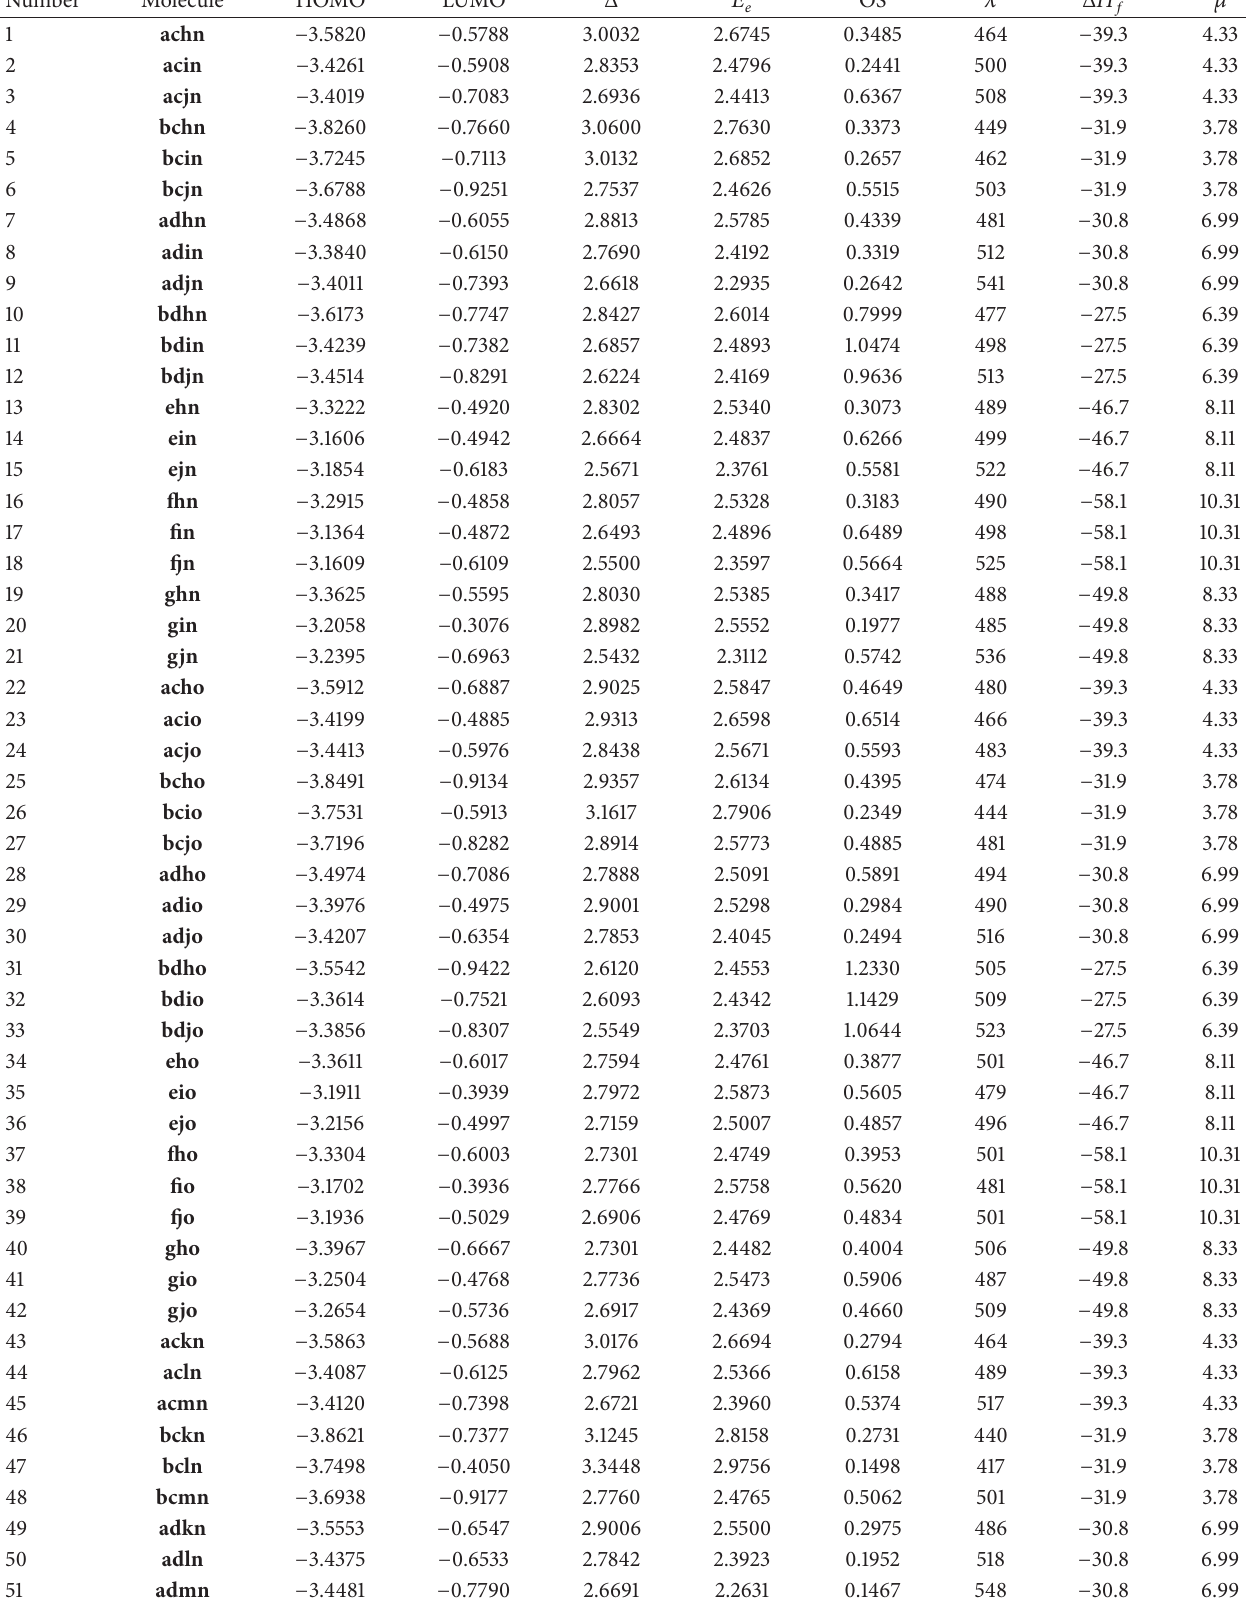
Table 1: Quantum characteristics for designed